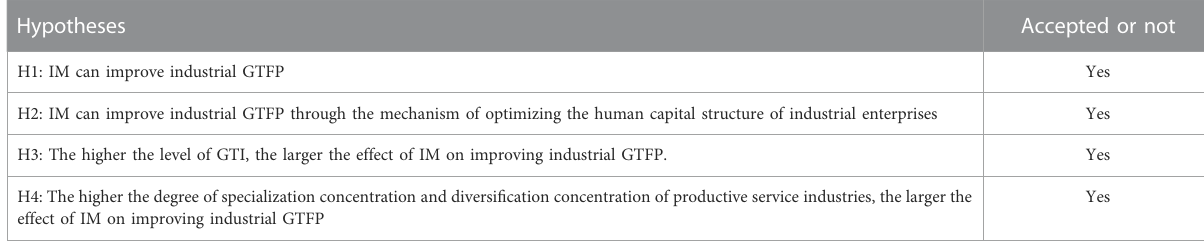
TABLE 7 Summary of research